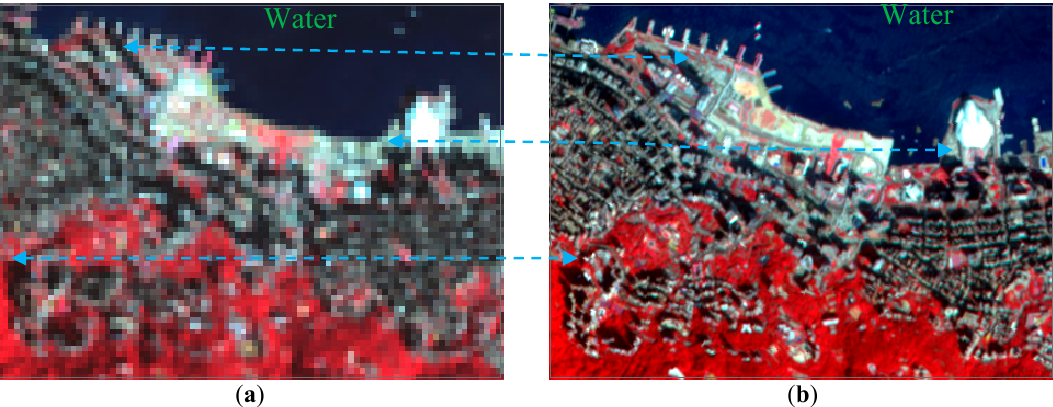
Figure 6. Building shadows in Hong Kong: ( a ) 30 meter Landsat-8 and ( b ) 5.8 meter ZY-3. The false-color images shown in Figure 6a generally distinguish water from shadow.